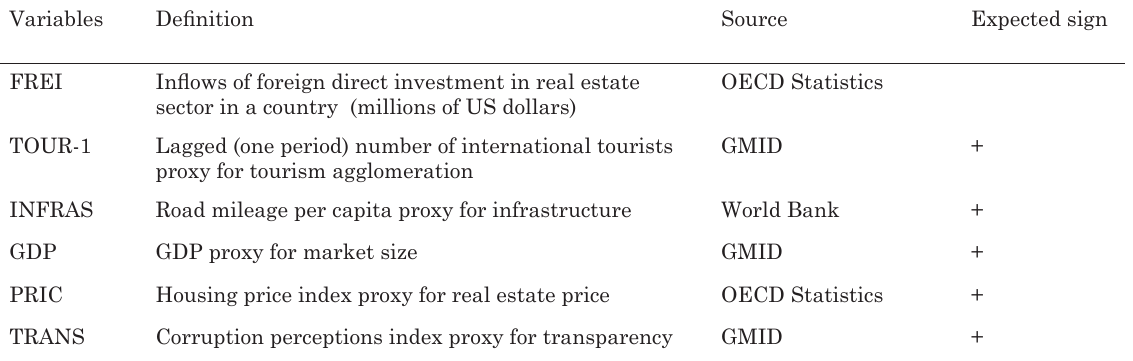
table 2. Description of dependent and independent variables